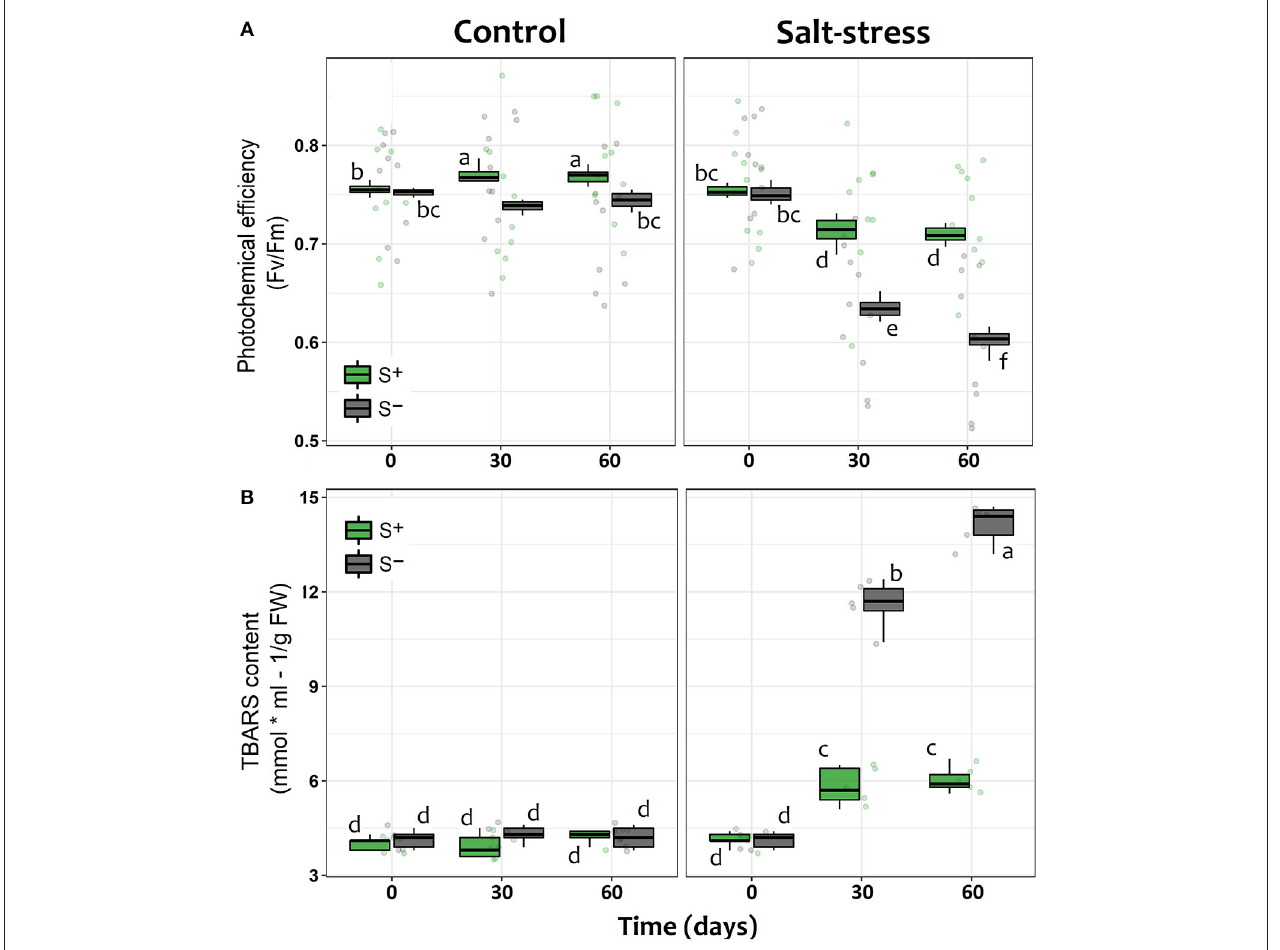
FIGURE 2 | Physiological performance of lettuce individuals measured as (A) the individual photochemical efficiency (F v /F m ) of photosystem II (PSII) and (B) the level of lipid cell membrane peroxidation (TBARS) measured in leaves at 0, 30, and 60 days after exposed to salt stress (200mM NaCl for “stressed” individuals) and inoculated with the Antarctic microbial consortium (S + plants). Control groups for both conditions (non-stressed and non-inoculated, S–) are also showed. The box-plot represents the interquartile distribution of the data for each experimental group. Different letters indicate significant a posteriori differences (Tukey test, α <